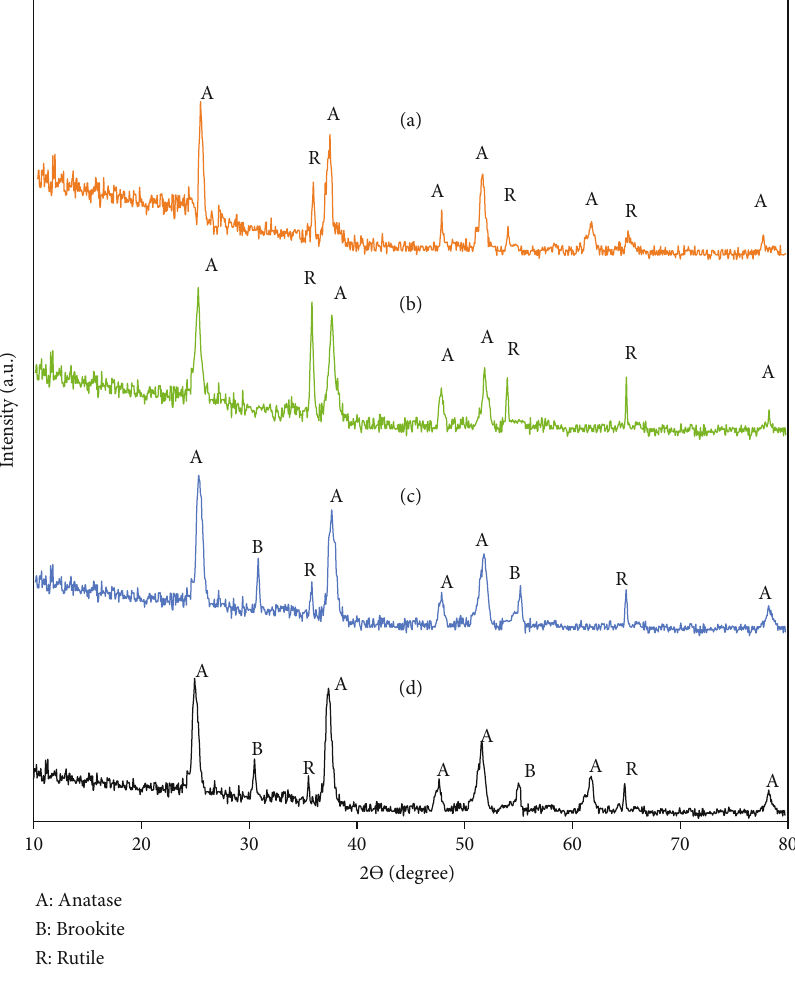
Figure 4: The XRD spectrum of (a) HT, (b) LT1, (c) LT2, and (d) LT3. Table 2: Calculated values for crystallinity state and nanocrystal size of